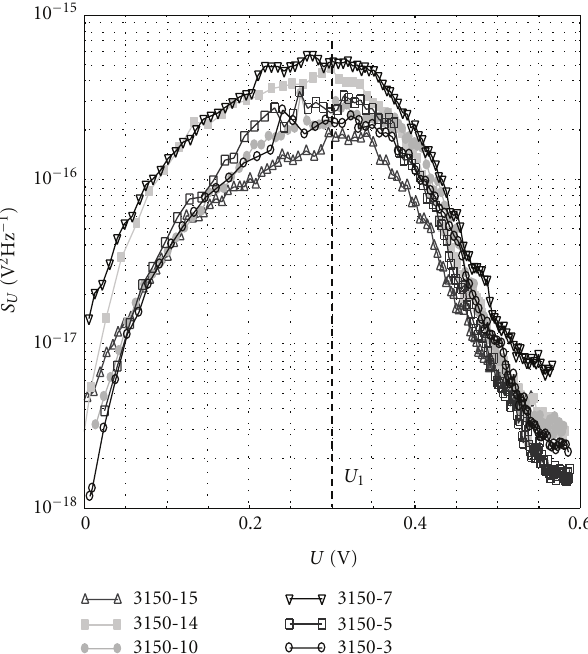
Figure 5: The noise spectral density as a function of forward voltage for group of samples 3150.